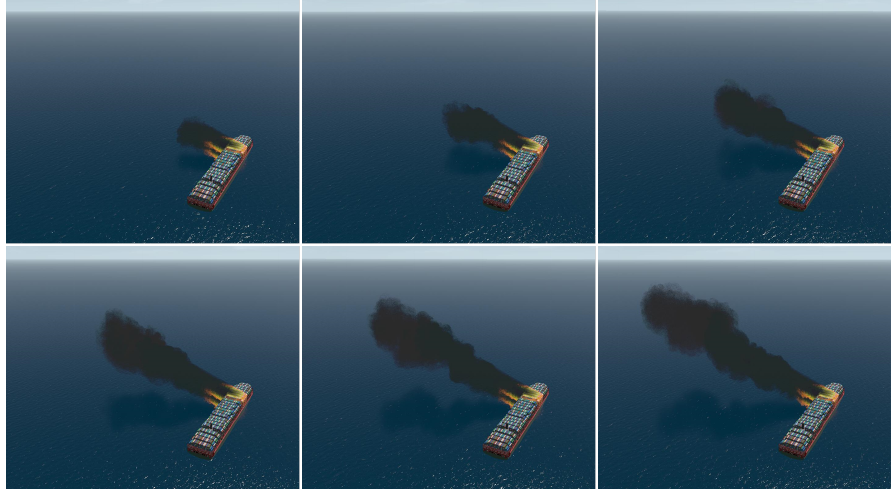
Figure 14. The thick smoke generated by the container